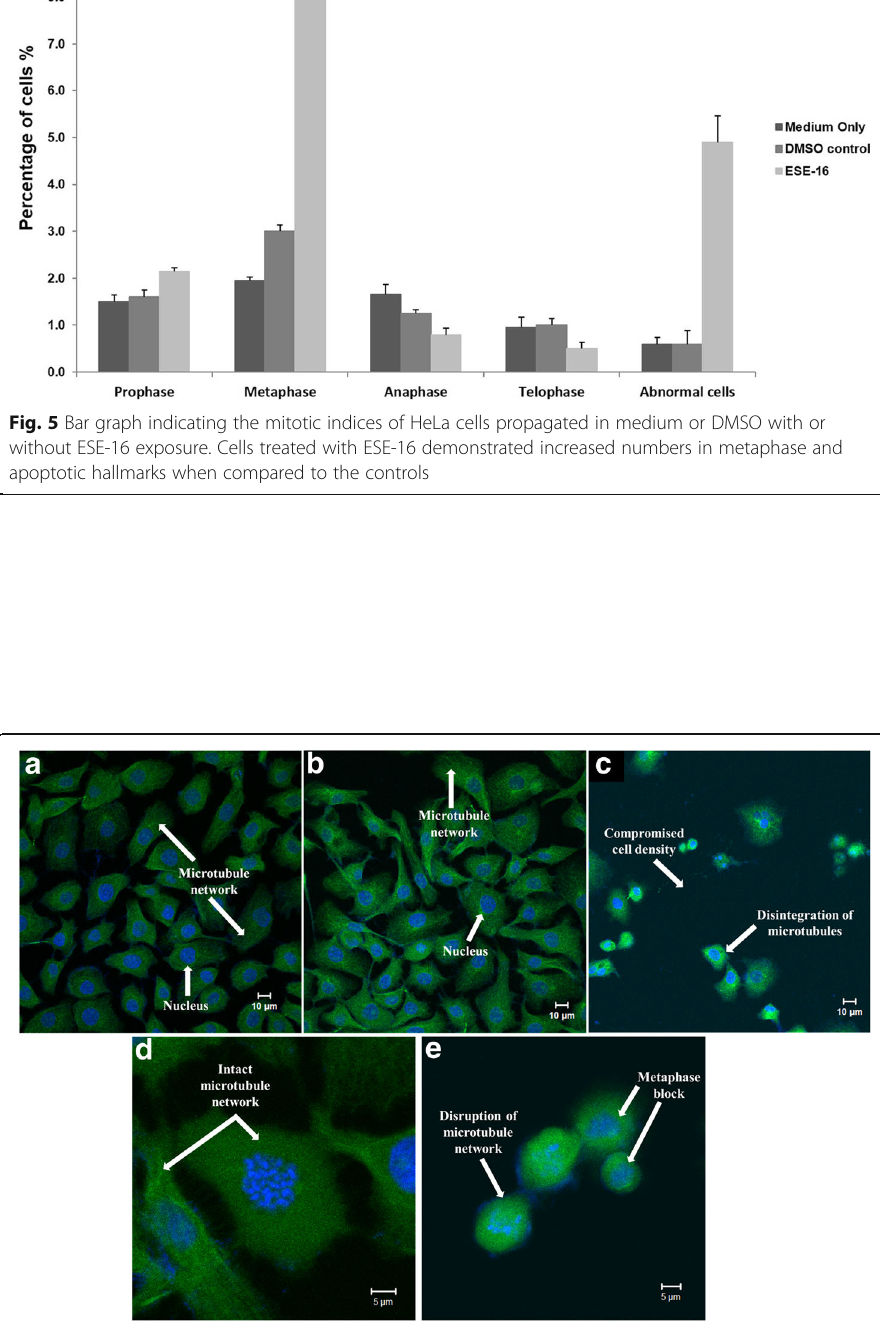
Fig. 6 Confocal microscope images of the tubulin structure in HeLa cells using immunofluorescence staining. a and b Medium-propagated cells ( a ) and vehicle-treated control cells ( b ) showed normal and intact microtubules. c HeLa cells treated with ESE-16 revealed a decrease in cell density and a complete loss and disruption of the microtubule network. d A HeLa cell in prophase with an intact microtubule network. e A HeLa cell after 24 h exposure to ESE-16, revealing an increased number of cells in metaphase with disintegrated